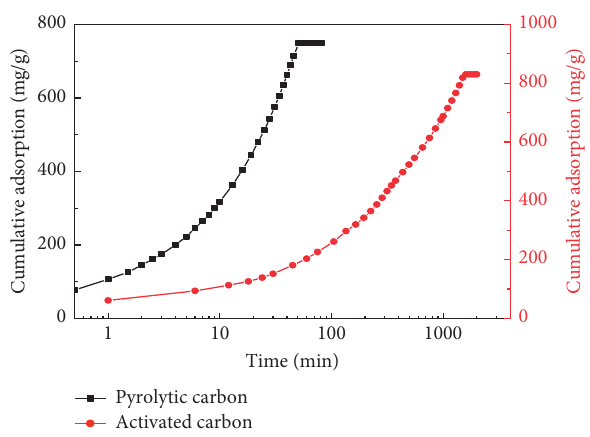
Figure 7: Cumulative adsorption comparison of pyrolytic carbon and activated carbon on diesel.